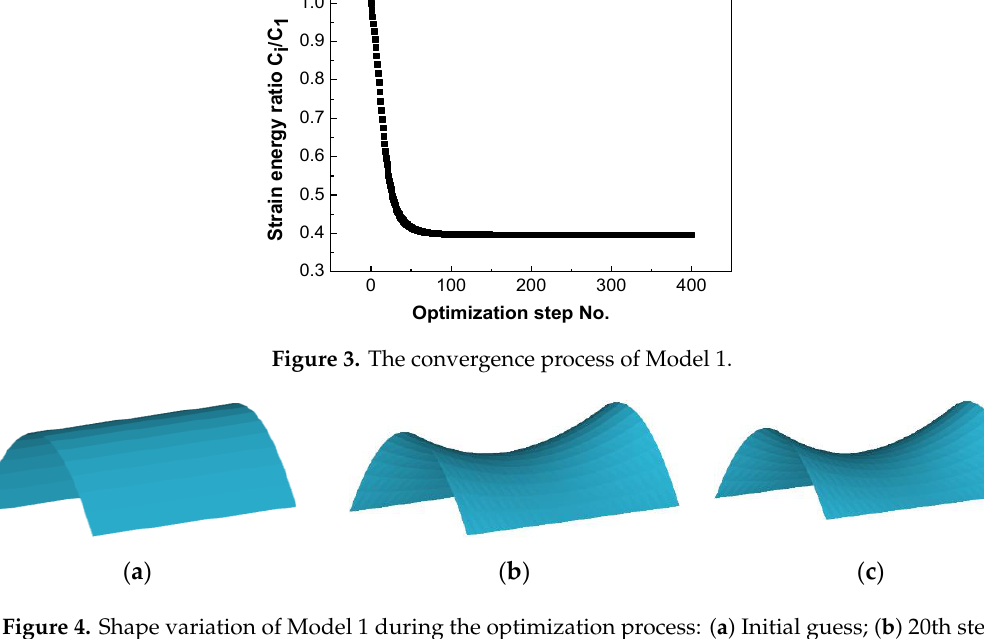
Figure 3. The convergence process of Model 1.